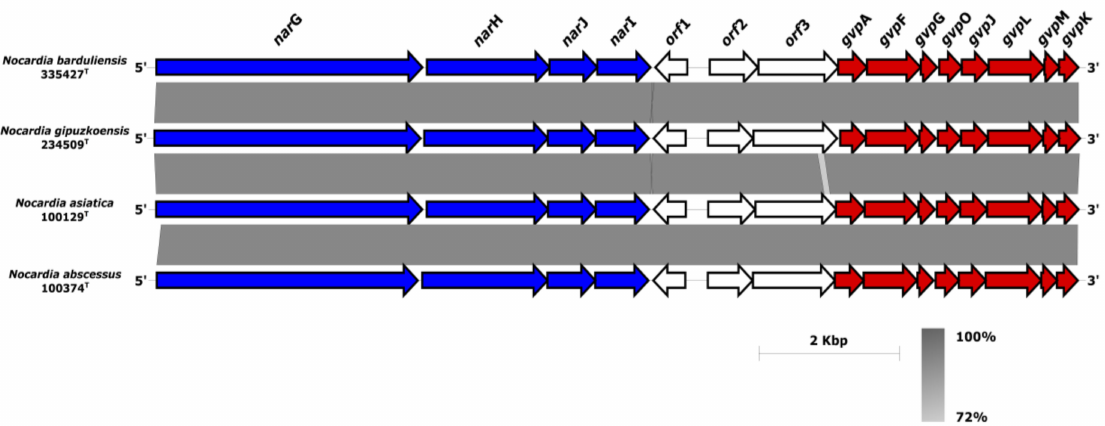
Figure 3. Synteny of the nar and gvp gene clusters sub-region in isolates 335427 T and 234509 T and their closest relatives. All the genes present on these clusters showed identity values over 72% between isolates 3355612 T and 234509 T and the closest